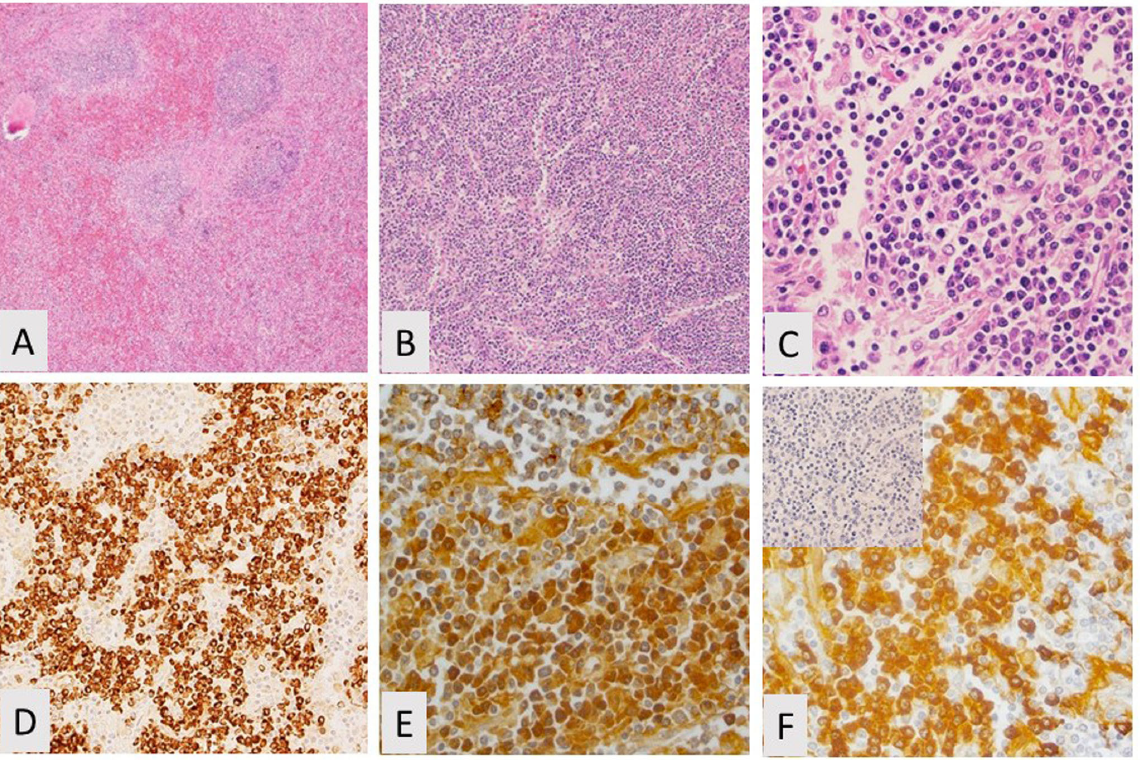
Figure 6. Lymphoplasmacytic lymphoma. ( A ) Splenic lymphopasmacytic lymphoma showing disrupted architecture, H&E, 20×; ( B ) focally showing a more diffuse pattern, H&E, 20×; ( C ) lymphocytes with a plasmacytic appearance, H&E, 200×; ( D ) immunohistochemistry (IHC) for CD138 is positive; ( E ) IHC is positive for CD20; ( F ) IHC for kappa is positive, lambda (in set) is negative.